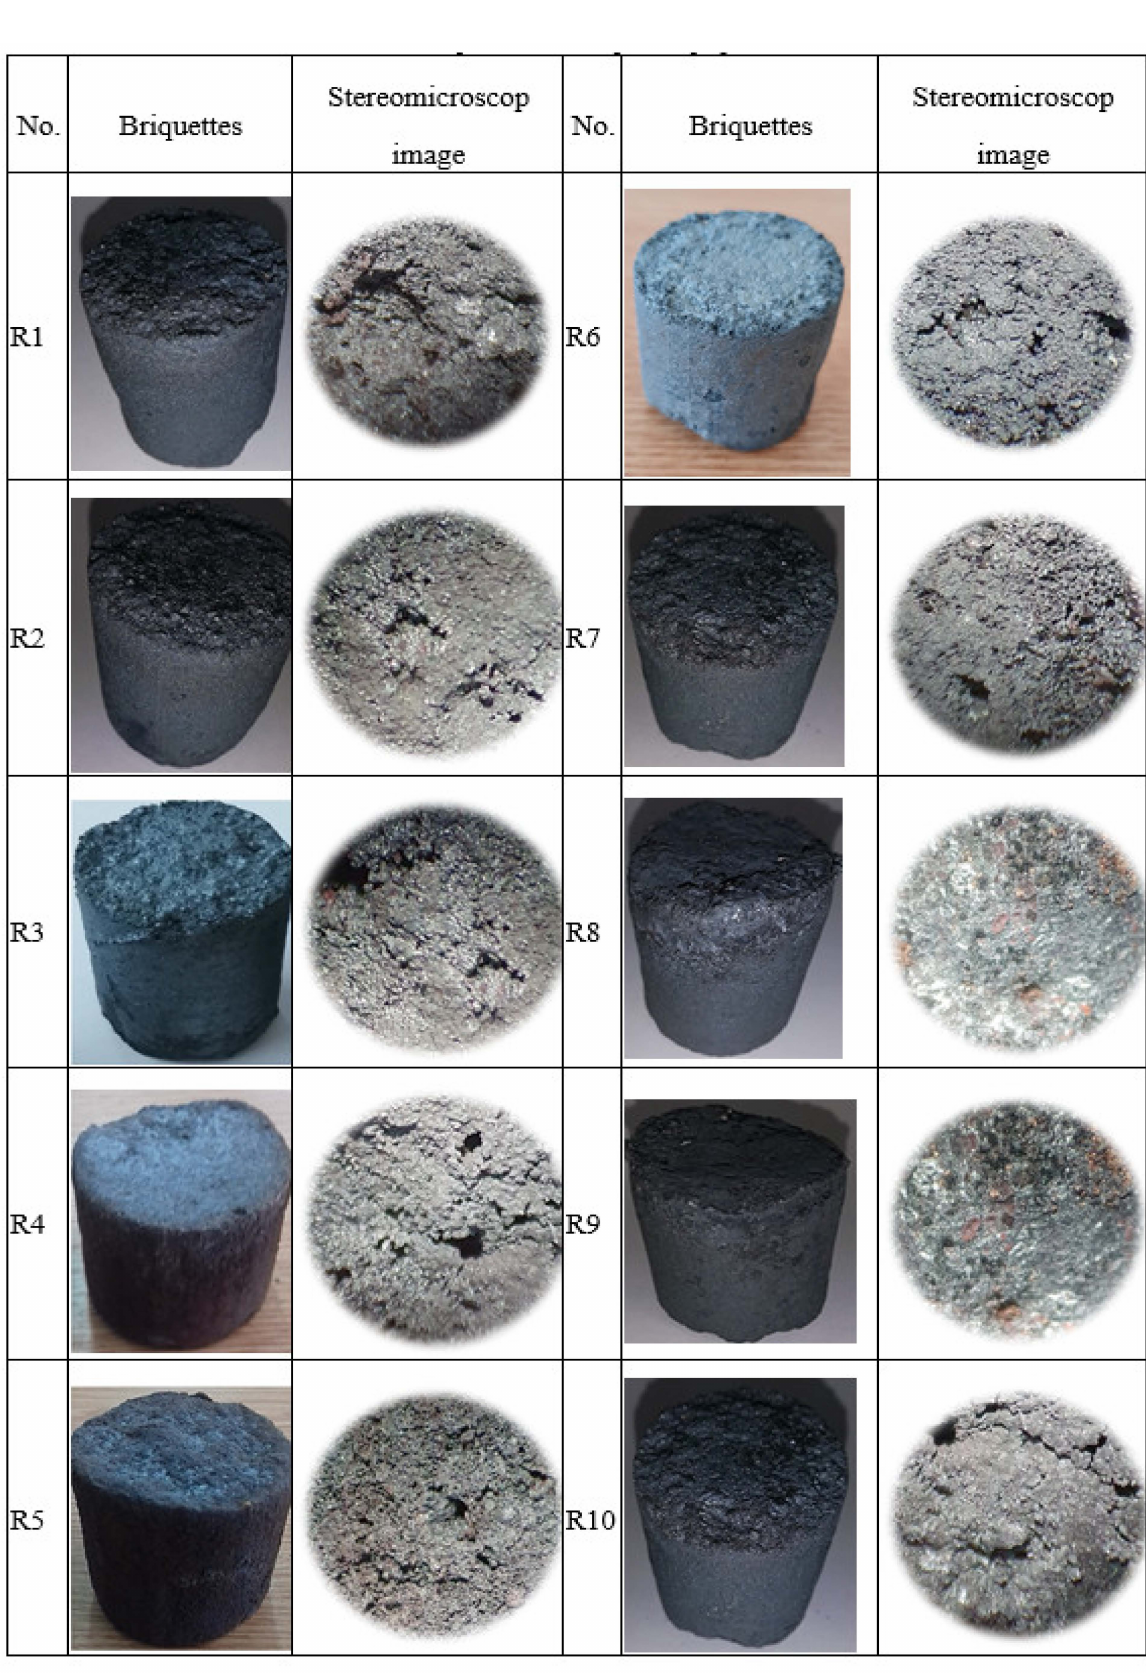
Figure 11. Experimental